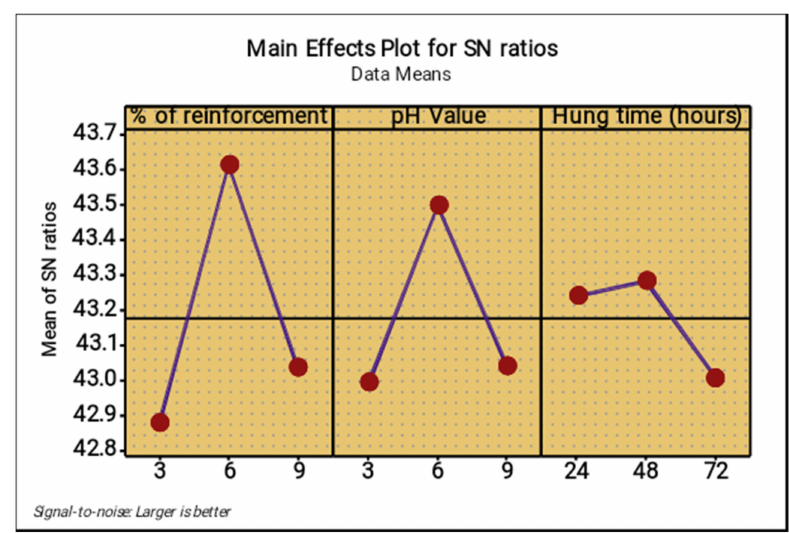
Figure 32. Main effect plot for S/N ratios (microhardness).